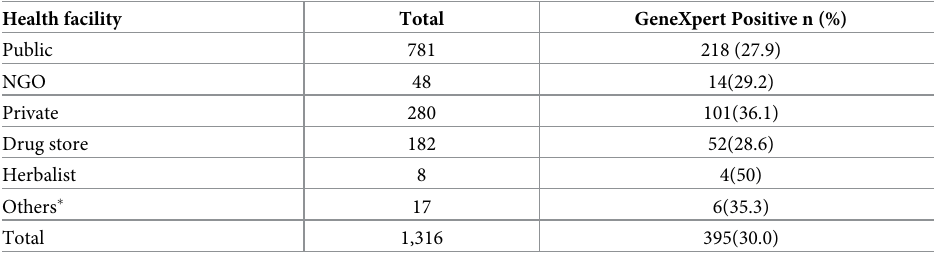
Table 3. GeneXpert results of the respondents given health facility initially visited (n =